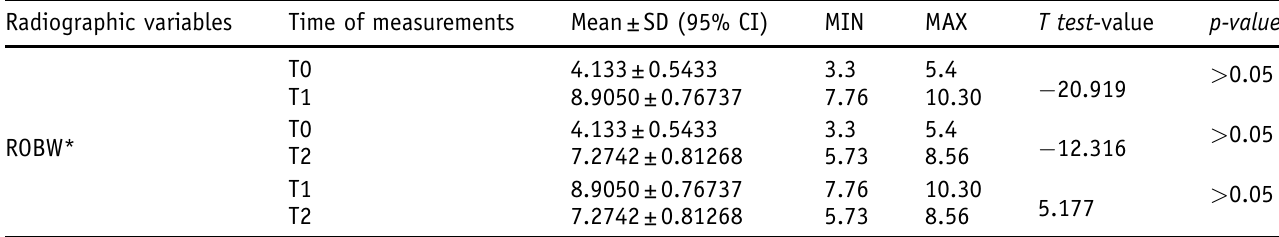
Table II. Two-way comparisons to study the differences between means of changes in the alveolar width overall gain radiographically in (T0-T1-T2)